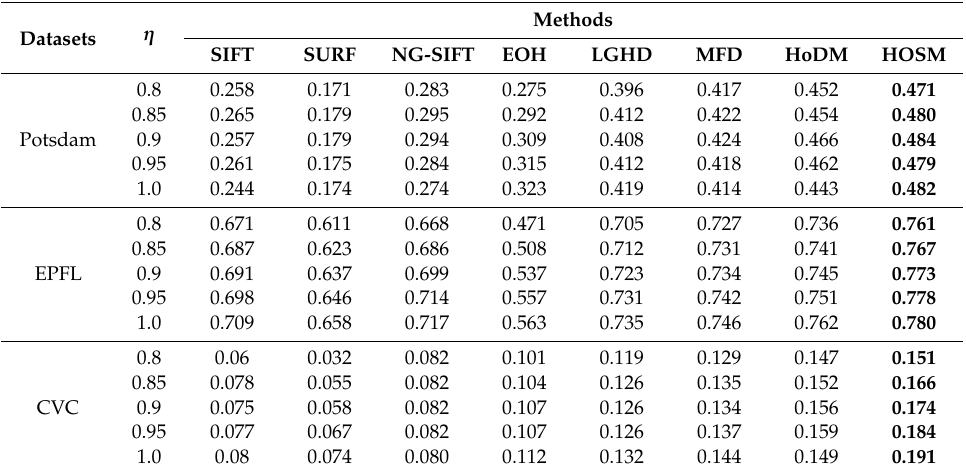
Table 3. Average of F1-score values for all eight methods on all three